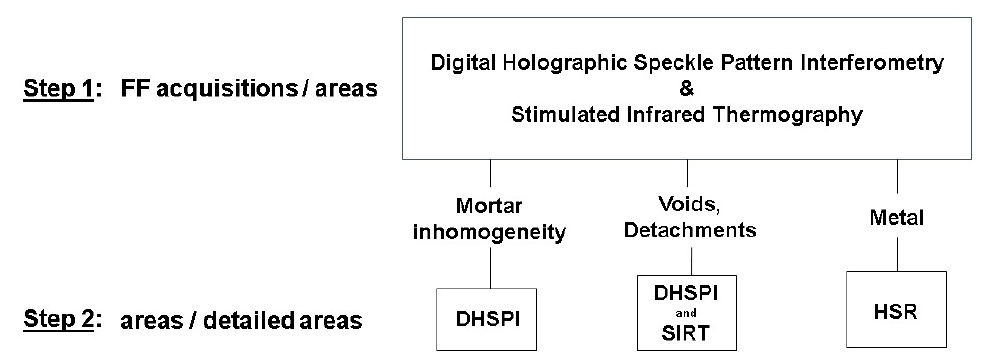
Figure 8. A proposed complementary DHSPI-SIRT and HSR approach for a complex subsurface structural evaluation of wall mosaics, based on the first laboratory experimental results. FF—full field; DHSPI—Digital Holographic Speckle Pattern Interferometry; SIRT—Stimulated Infrared Thermography; HSR—Holographic Subsurface Radar. After Chaban et al. [73].